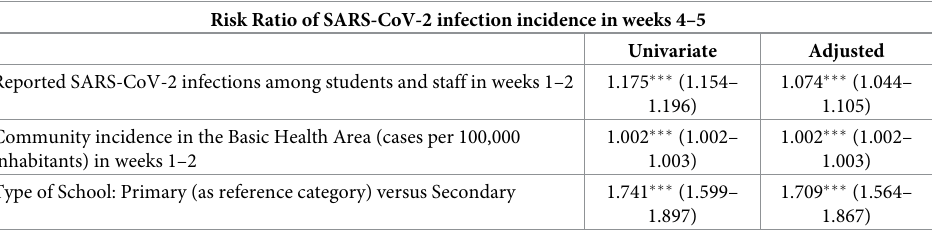
Table 2. Univariate and multivariate multilevel Poisson regression analysis of potential determinants for inci- dence of SARS-CoV-2 cases in public schools in Catalonia in weeks 4–5. Risk Ratio of SARS-CoV-2 infection incidence in weeks